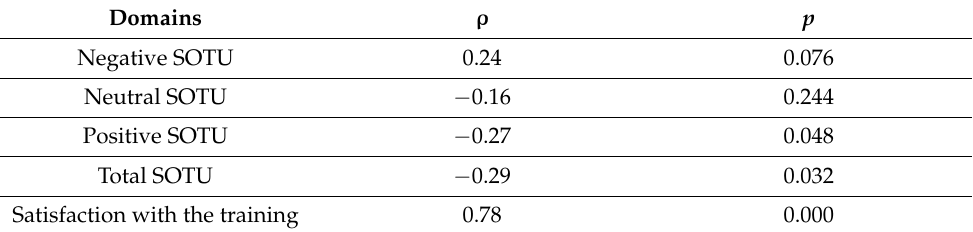
Table 5. Correlation coefficient between eHEALS, SOTU, and satisfaction with training, and their